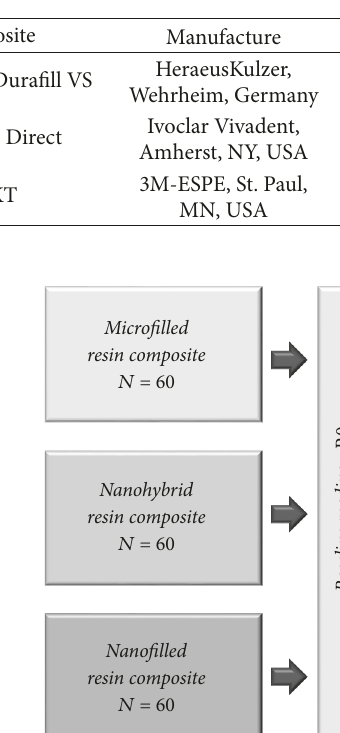
Table 1: Resin composites used in this study.